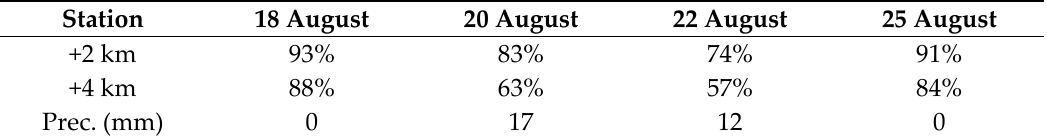
Table 1. Share of Petnica spring influence to Banja River